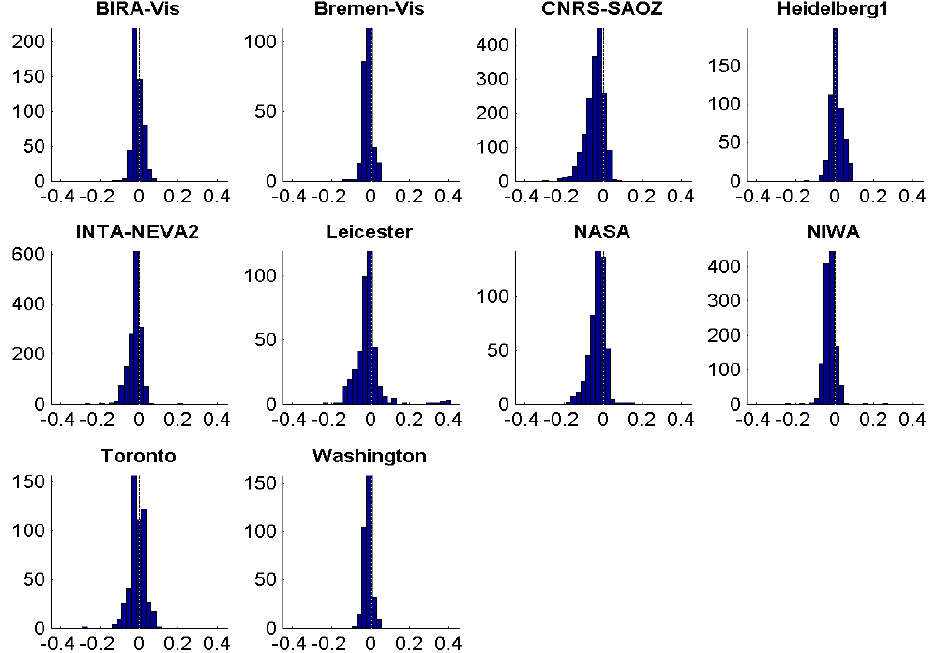
Fig. 17. Histograms of the differences between zenith-sky results from each instrument and results interpolated from INTA-RASAS2. The histograms are for the whole campaign, and are normalised by the difference between the mean INTA-RASAS2 slope and the mean of all instruments. If both INTA-RASAS2 and the other instrument were of high standard, one would expect a narrow and symmetric histogram, though not necessarily symmetric about zero. The fact that several histograms are narrow and symmetric strongly suggests that they and INTA-RASAS2 are both of high standard.